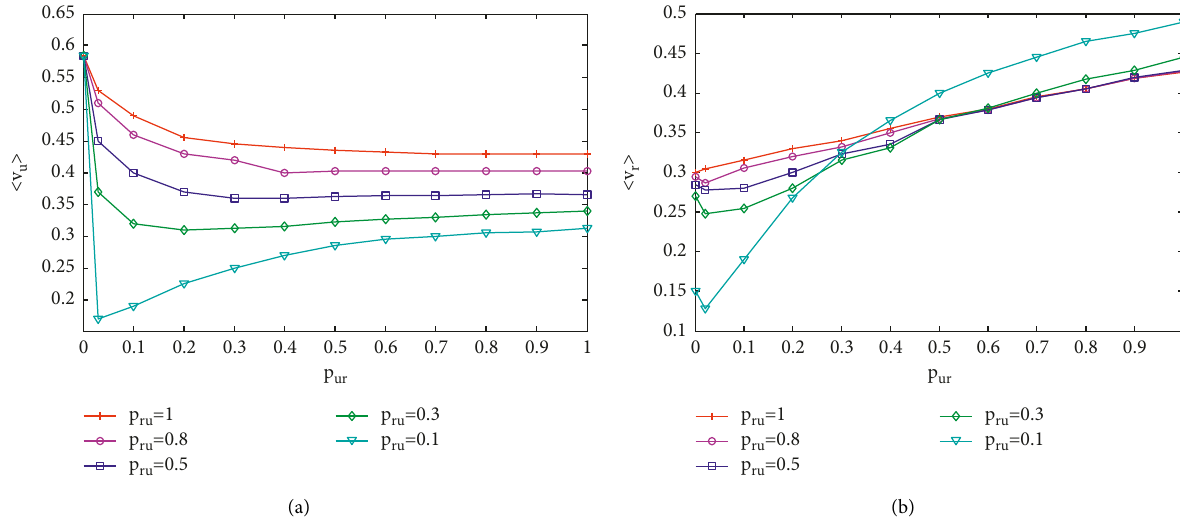
Figure 5: When ρ � 0.7 and L � 100, (a) the relationship between the average velocity of upward vehicles and p between the average velocity of right-moving vehicles and p ur , with different p ru